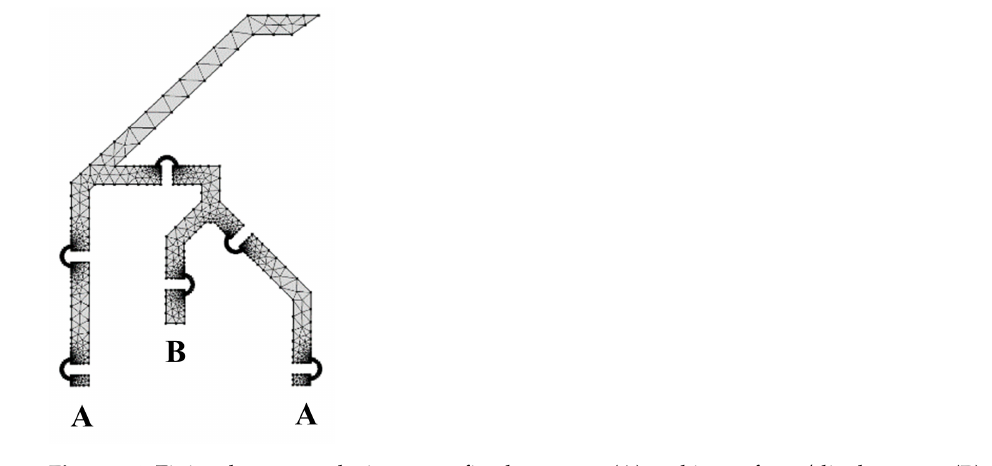
Figure 14. Finite element analysis set-up: fixed supports ( A ) and input force/displacement ( B